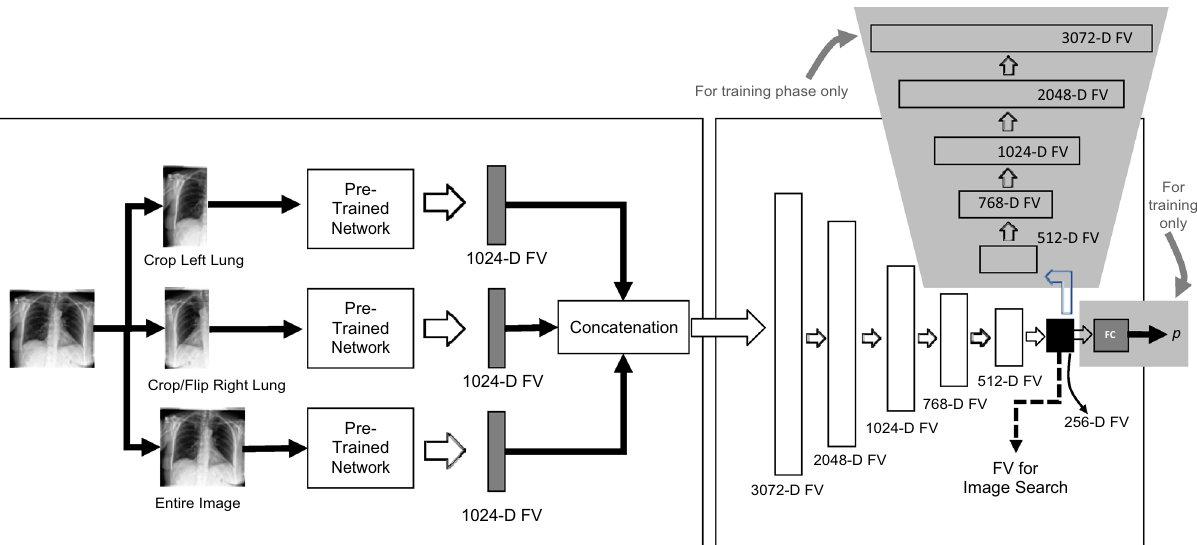
Figure 6. A graphical illustration of AutoThorax -Net. Three extracted feature vectors (FVs) (left) are concatenated and fed into into an encoder to compress them into 256 values for image search. During training the same compressed FV is used as input to a fully connected layer (FC) to classify images as pneumothorax with a likelihood of p